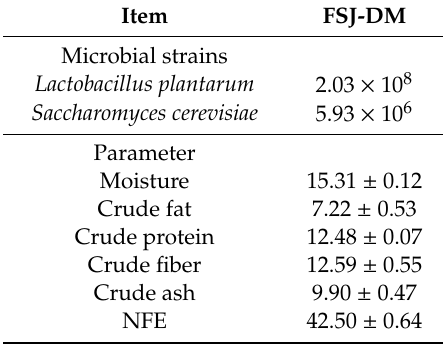
Table 2. Microbial concentration (cfu / g) and chemical composition (%) of fermented Saccharina Japonica and Dendropanax morbifera